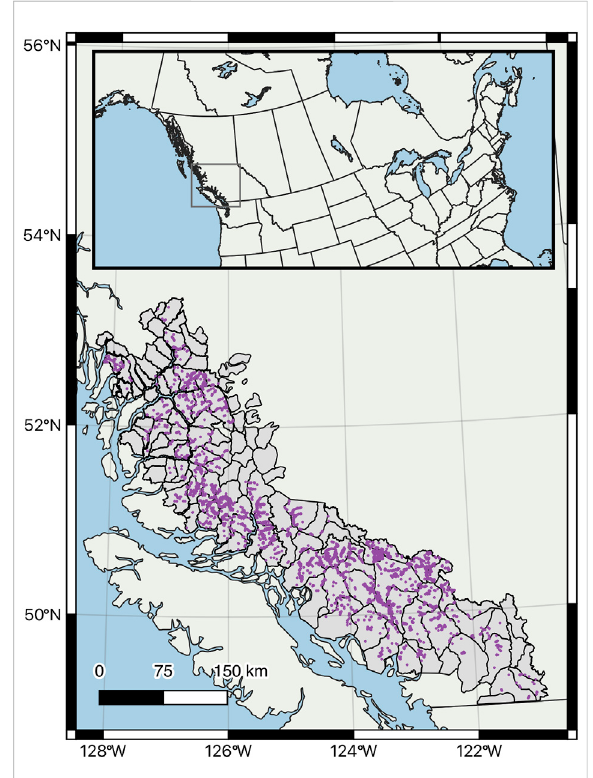
FIGURE 1 Study area in the Paci fi c coastal region of British Columbia, Canada. Population unit boundaries are illustrated, which served as the area over which the habitat suitability model was projected. Purple points illustrate the distribution of